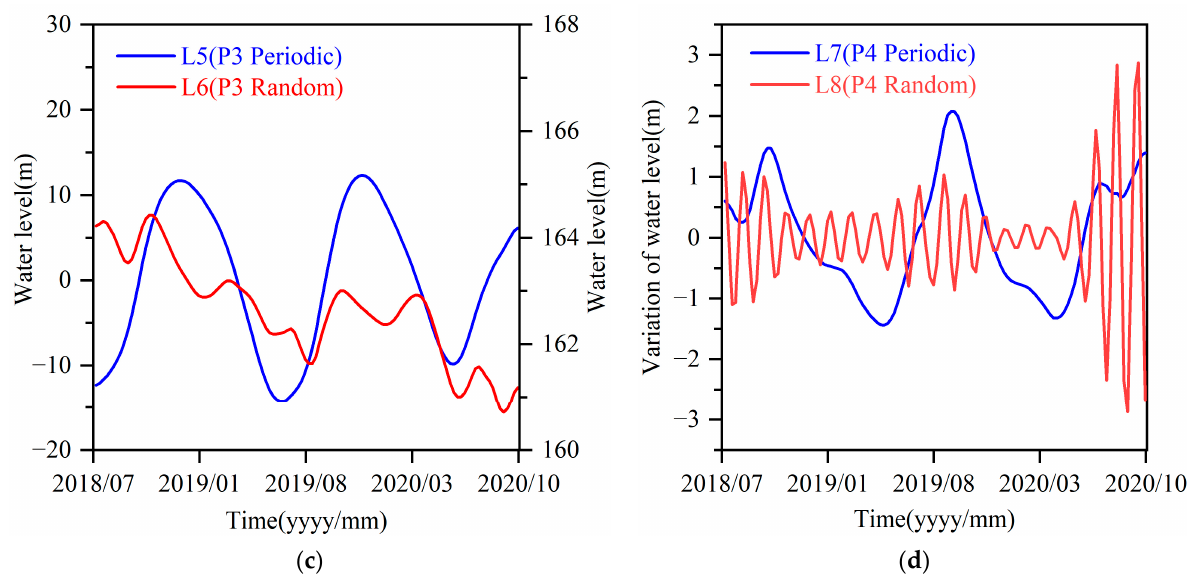
Figure 7. Decomposition results of the influencing factors: ( a ) decomposition result of P1; ( b ) decomposition result of P2; ( c ) decomposition result of P3; ( d ) decomposition result of P4.